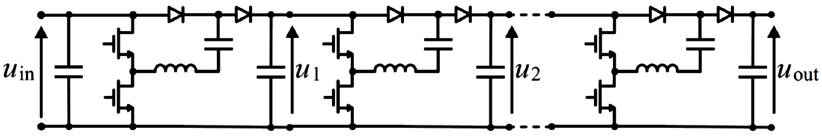
Figure 10. SCVD series in a high-voltage-gain converter.